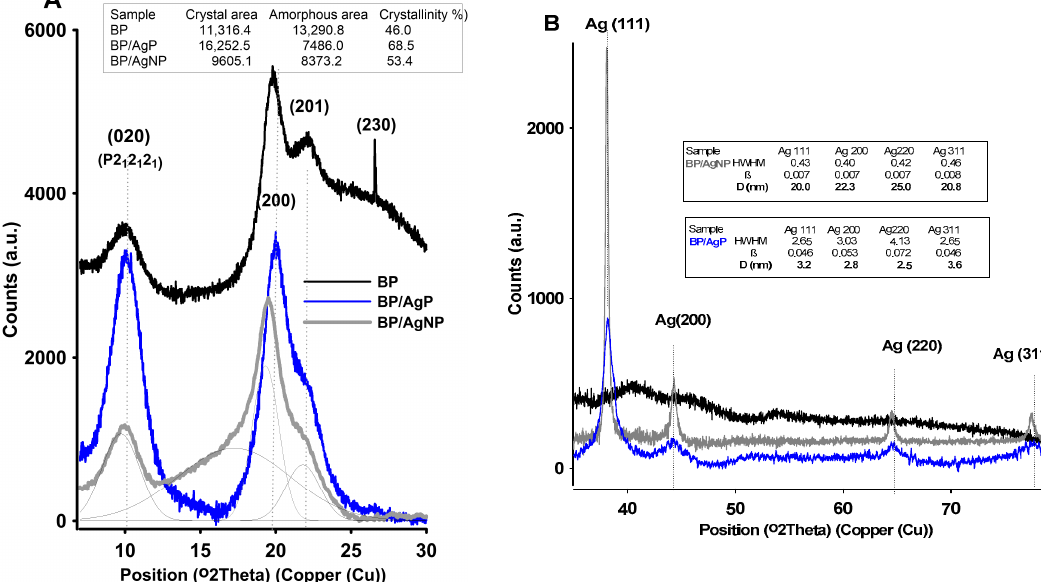
Figure 5. X-ray powder diffraction pattern of the investigated materials, BP, BP/AgP, and BP/AgNP. ( A ) XRD peaks between the range of 5–30°of 2 θ of chitosan phase and ( B ) XRD peaks between the range of 30–80°of 2 θ of crystal silver phase.